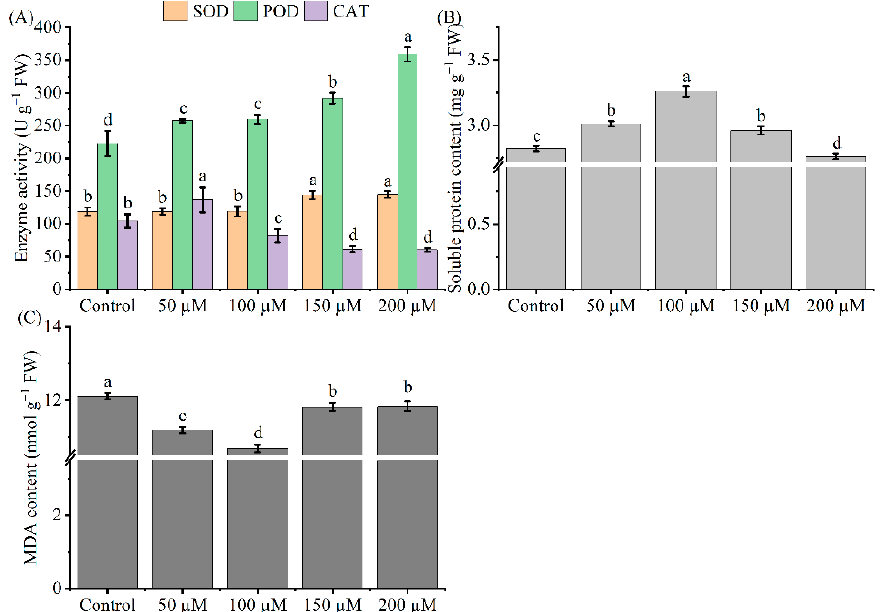
Figure 3. Effects of exogenous melatonin application on antioxidant enzyme activity ( A ), soluble protein ( B ), and MDA ( C ) content of Cd-stressed tea seedlings. The data represent means ± standard deviations for three replicates. Different letters indicate groups that are significantly different at p < 0.05.